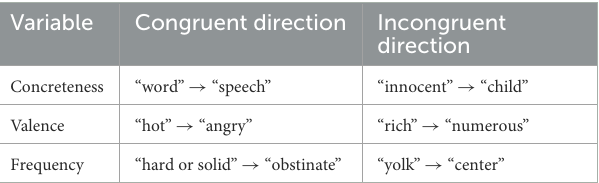
TABLE 1 Examples of semantic change (source meaning → target meaning) with directions congruent and incongruent with the prediction made under each variable.